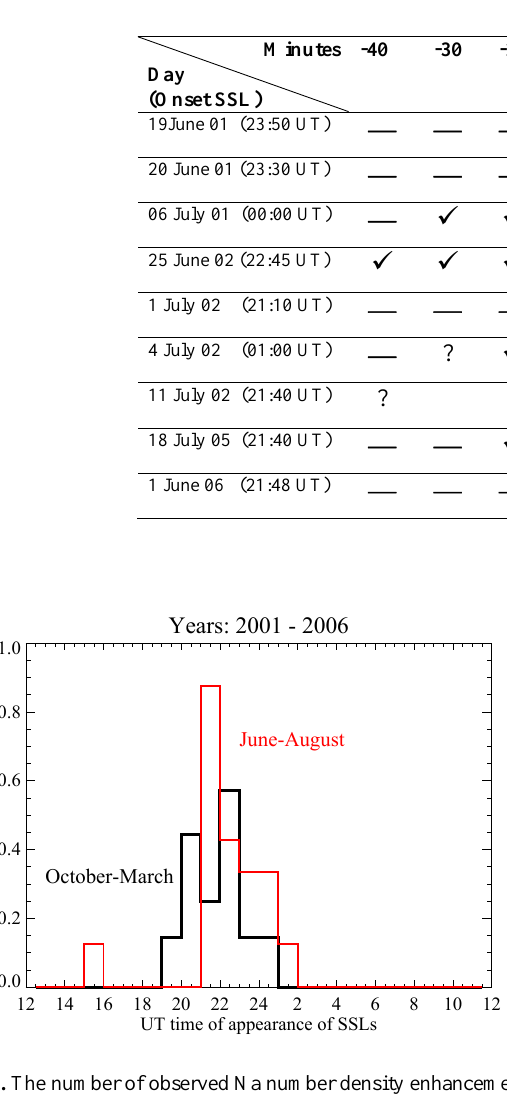
CO 2 and H 2 O (Collins et al.,